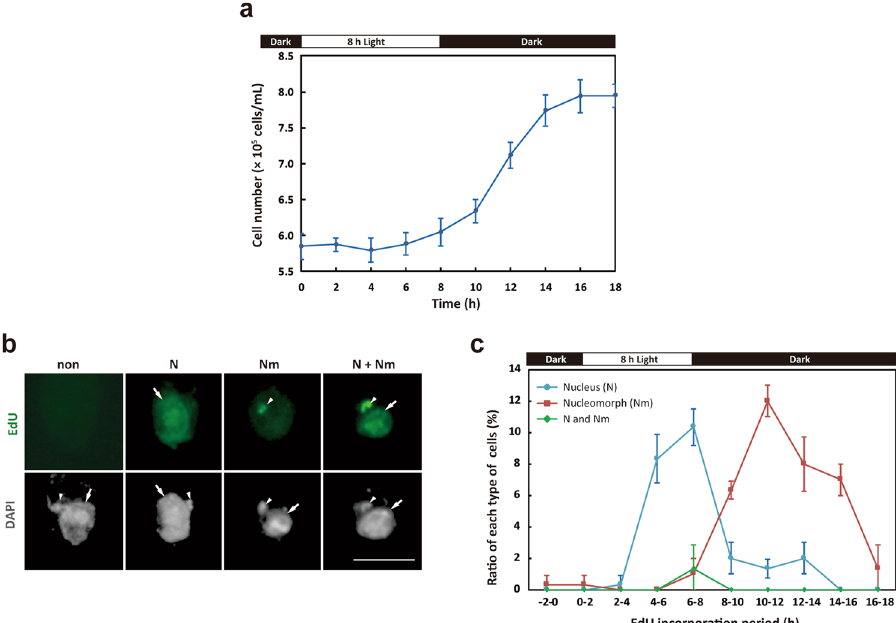
Figure 4. The timing of nucleus and nucleomorph DNA replication in the synchronous G . theta culture. ( a ) Change in the cell density in the culture synchronized by the 8-h light/16-h dark cycle. The error bar represents standard deviation of six technical replicates. ( b ) Fluorescent micrographs showing the EdU-labelled nucleus and nucleomorph. DIC, images of differential interference contact; DAPI, DNA stained with DAPI. The arrow and arrowhead indicate signals of nucleus and nucleomorph, respectively. Scale bar = 5 µ m. ( c ) Change in the frequency of cells with EdU-labelled nucleus (blue), cells with nucleomorph (red), and cells with both EdU-labelled nucleus and nucleomorph (green). The error bar indicates standard deviation of three technical